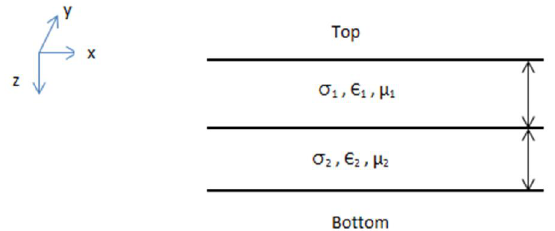
Figure 1: A two horizontal layer model, each layer has depth l, conductivity σ, dielectric constant Є, and magnetic permeability μ. The top and bottom layers (Boundaries) extent to infinity along z. This model can be represented as an equivalent transmission line [1], with two sections corresponds to two layers. As compared to free space, subsurface layers can be considered as impedance lines connected end to end, as illustrated in Figure 2.